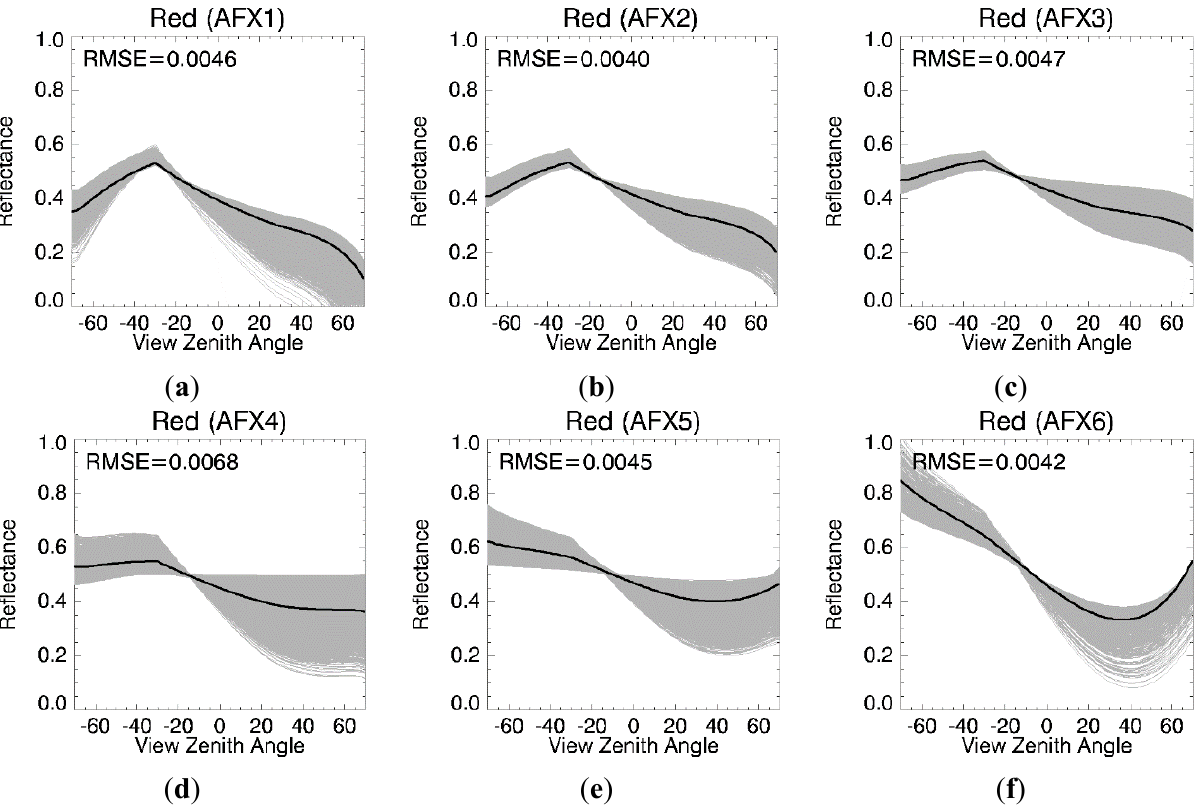
Figure 2. BRDF shapes of the normalized MODIS BRDFs of five-year time-series data of 1000 randomly sampled pixels (grey lines) for tile H20V11 and the corresponding BRDF archetype (black lines) in the principal plane at a solar zenith angle of 30° for the MODIS red band. ( a – f ) refer to the first–sixth BRDF archetypes. Positive and negative view zenith angles stand for forward and backward scattering direction